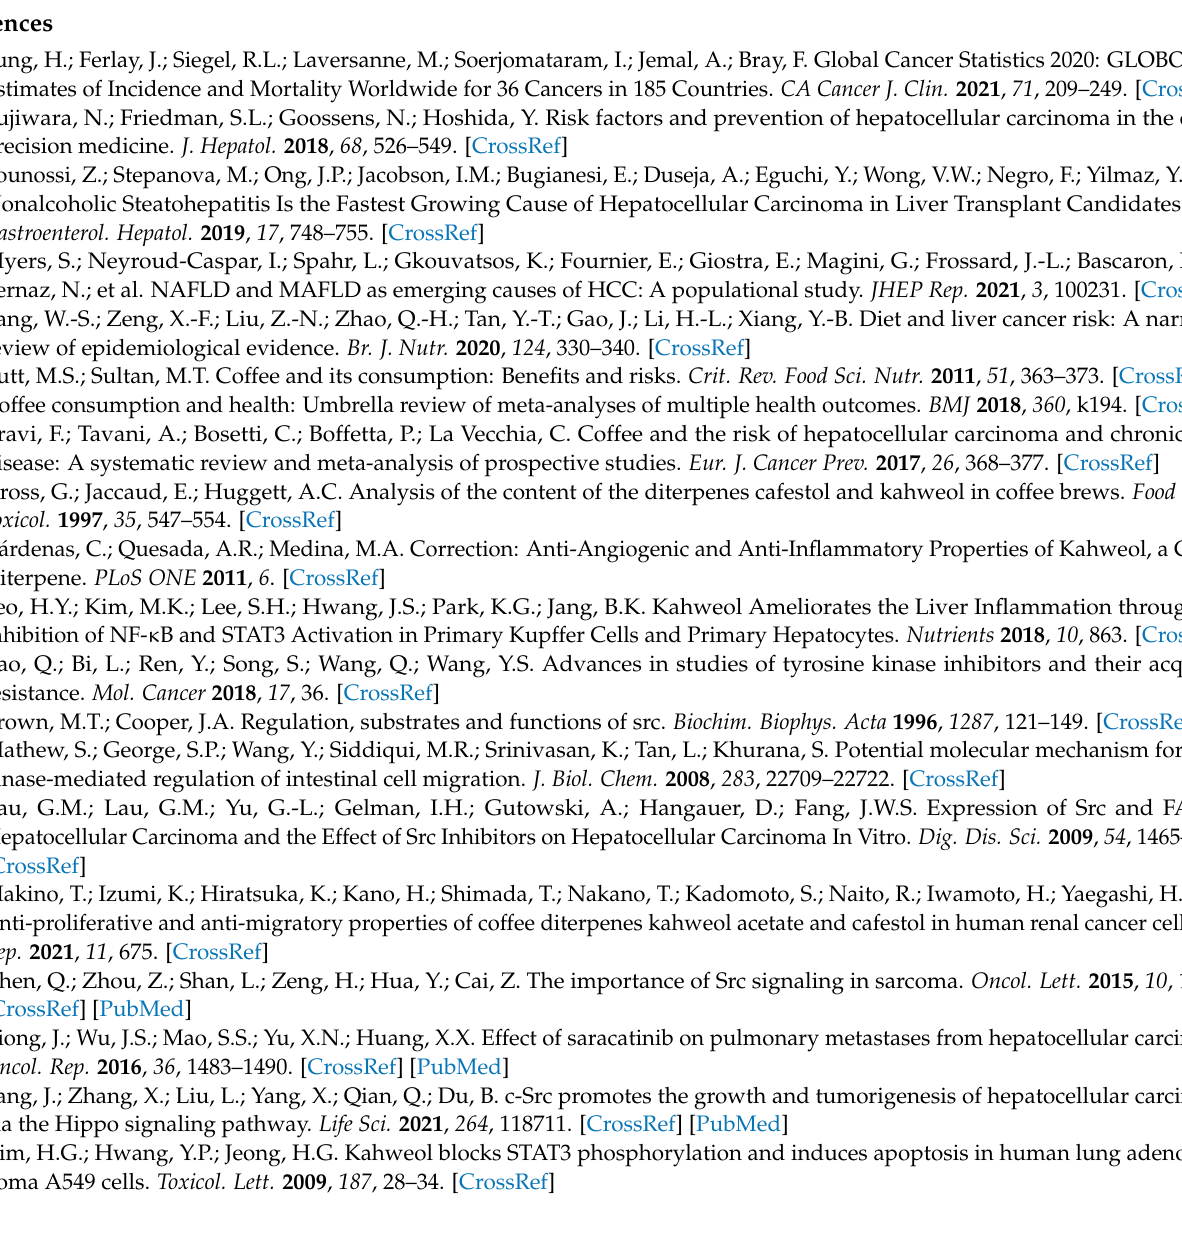
in CRC, Figure S1: PP2 induced apoptosis in HCC cells, Figure S2: PP2 blocks mTOR activation in HCC cells, Figure S3: The correlation among the expressions of Src and Akt in HCC